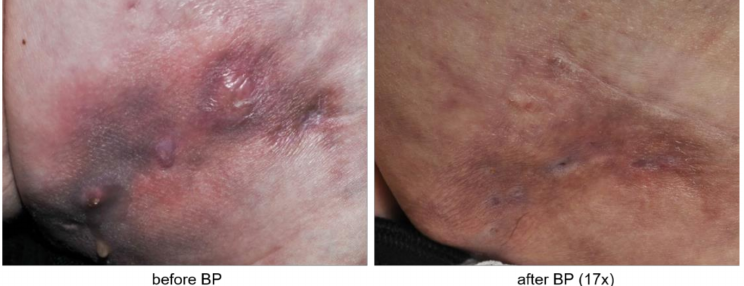
Figure 2. Representative clinical pictures of calcinosis cutis before and after bisphosphonate (BP) therapy (17 cycles).